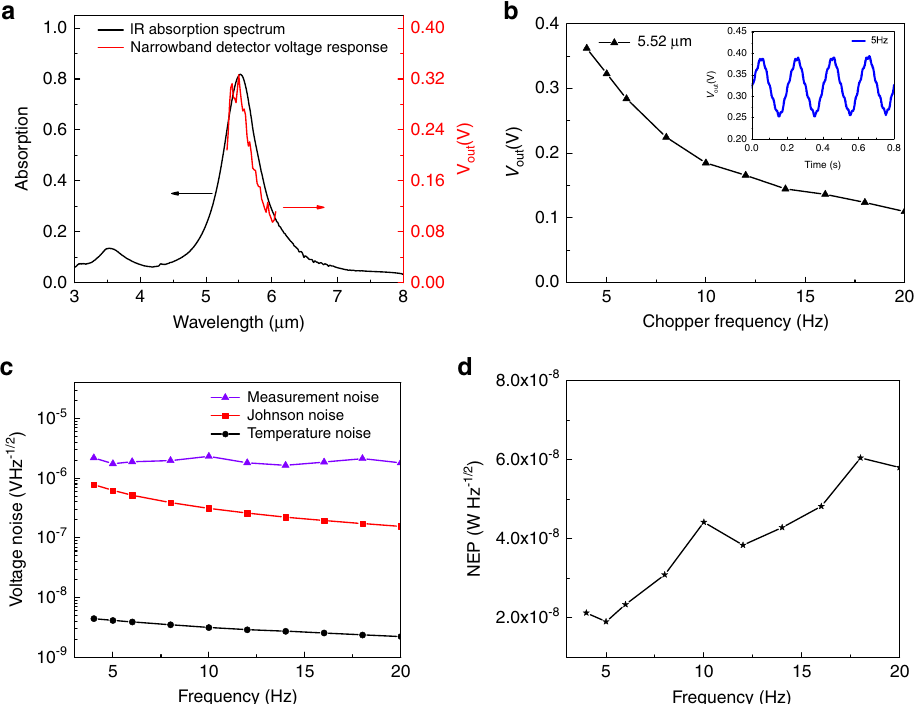
Fig. 4 Photoresponse of detector. a The measured voltage responses of one narrowband detector as a function of the wavelength of the input beam, compared with the absorption spectra of the integrated PMAs. The input beam is from a tunable quantum cascade laser and is modulated by an optical chopper at the frequency of 5 Hz. b The voltage response of the detector as a function of the chopping frequency. The inset is the time-domain voltage response of the narrowband detector with a peak wavelength of 5.52 µ m. c The measured fl uctuation (total noise) in the output voltage of the detector without input optical power, and the calculated values of two major sources of noise: temperature noise and Johnson noise as a function of the frequency. d The noise equivalent power calculated from the measured total noise and the responsivity of the narrowband detector (5.52 µ m). Source data are provided as a Source Data fi